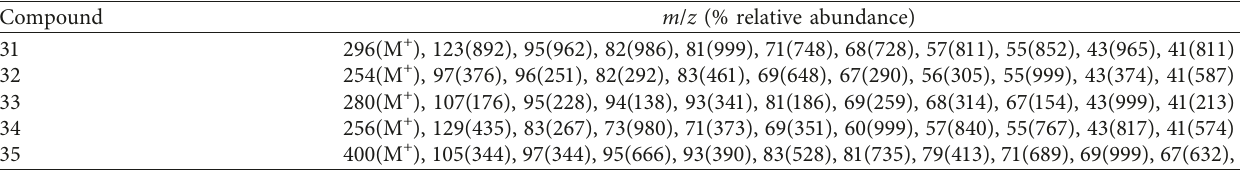
Table 21: Mass spectra of compounds 31–35 of whole plant n -hexane fraction of Achillea wilhelmsii (WHFAW).